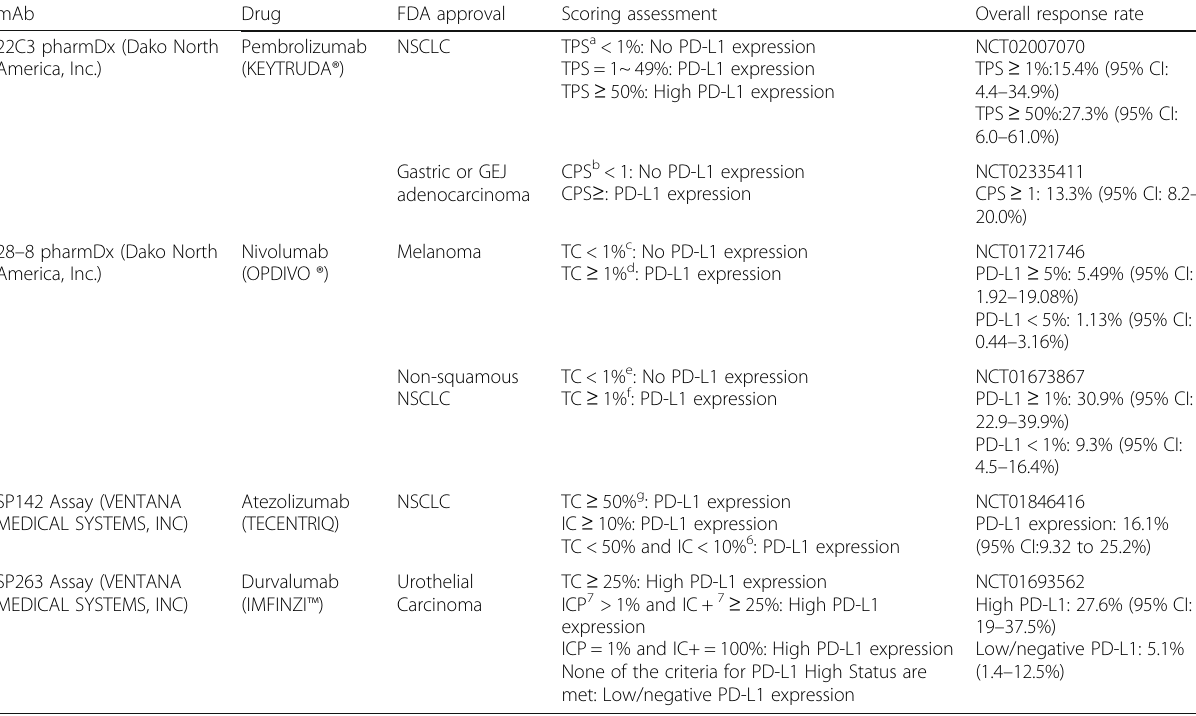
Table 1 The FDA-approved anti-PD1 drug and PD-L1 assessment mAb Drug FDA approval Scoring assessment Overall response rate 22C3 pharmDx (Dako North America, Inc.)